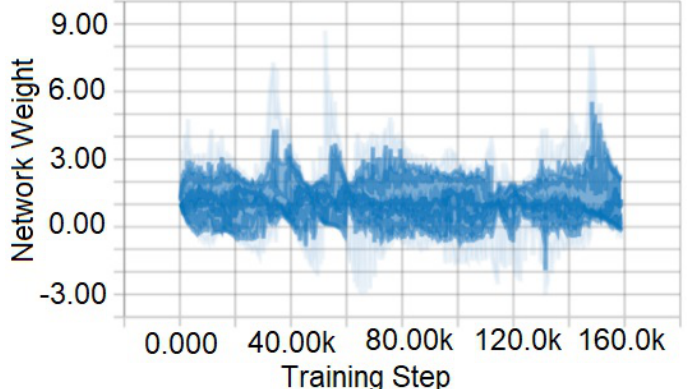
Figure 16. Training data before normalization.